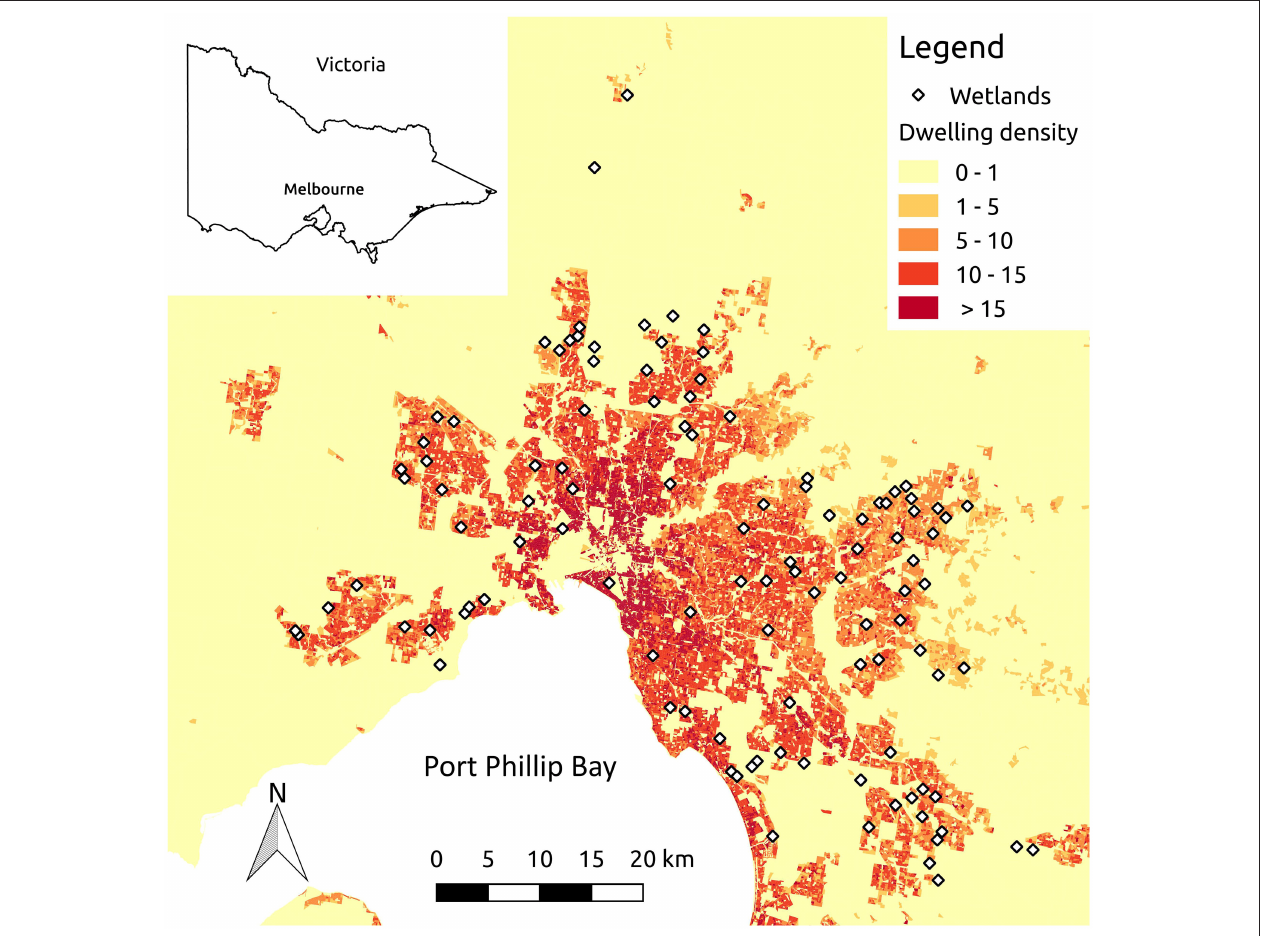
FIGURE 1 | Site locations in relation to the distribution of housing density across Melbourne. Housing density is measured as the number of dwellings per hectare derived from 2011 census (ABS,